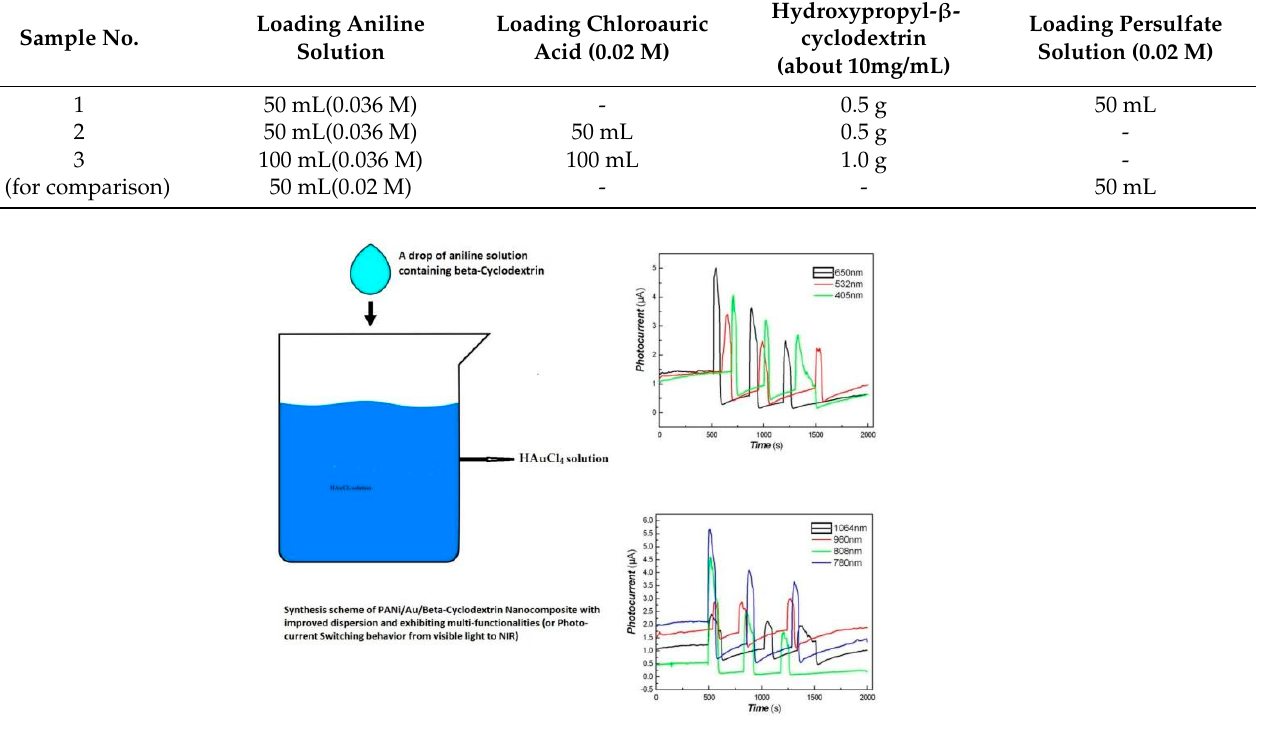
Table 1. Composition of experimental PANi/Au nanocomposite containing beta-cyclodextrin.